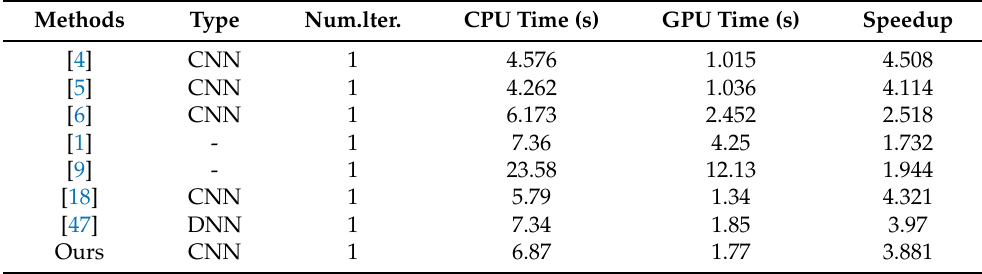
Table 8. Comparison of running times. The data in Table 8 include the average running time of each image on the CPU/GPU, which is obtained by dividing the total time spent on testing the eight models on the ImageNet by the total number of images. Methods Type Num.lter. CPU Time (s) GPU Time (s)